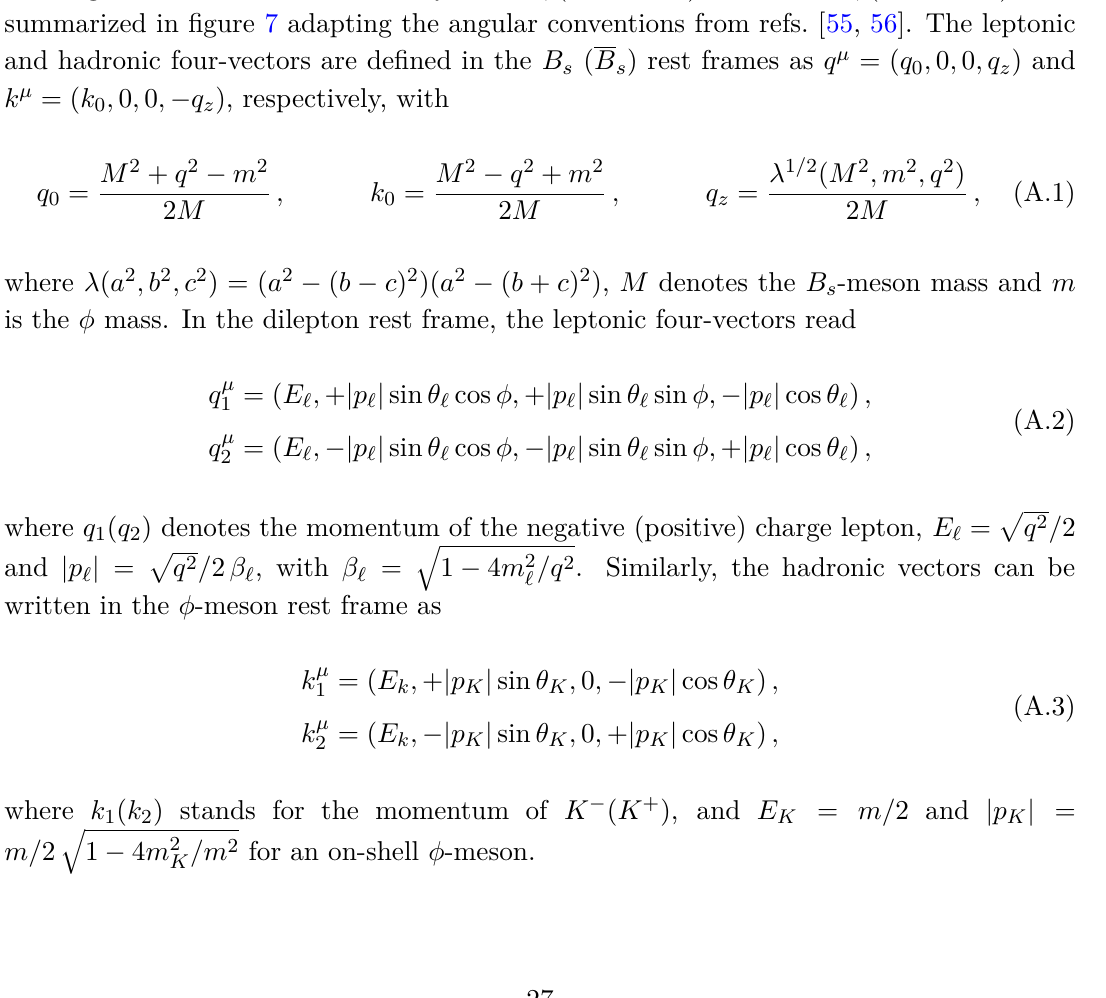
Figure 7 . Angular convention for the decays B s → φ ( → K − K + ) ‘‘ and The angles θ and θ are defined in the di-lepton and φ rest-frames, respectively. The angle φ is ‘ K defined between the K + K − and ‘ + ‘ − in the B rest frame and, although not shown in this diagram, it can be unambiguously extracted from eq. (A.2) and